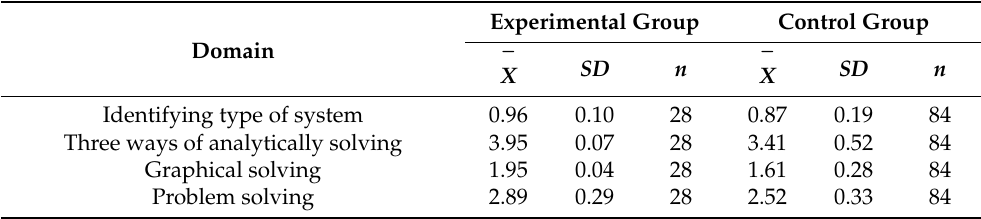
Table 2. Descriptive results by mathematics domain for the experimental and control